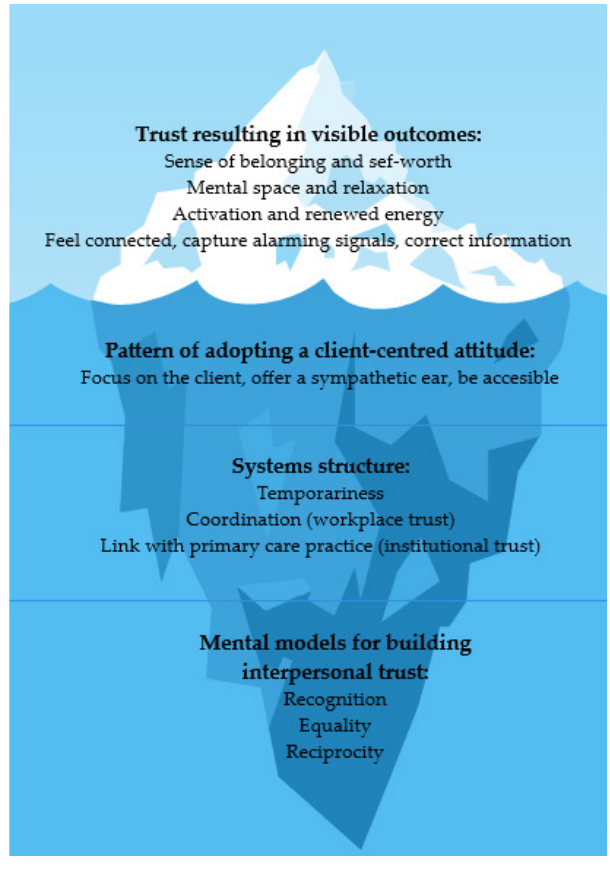
Figure 3. Program theory presented in the iceberg model.